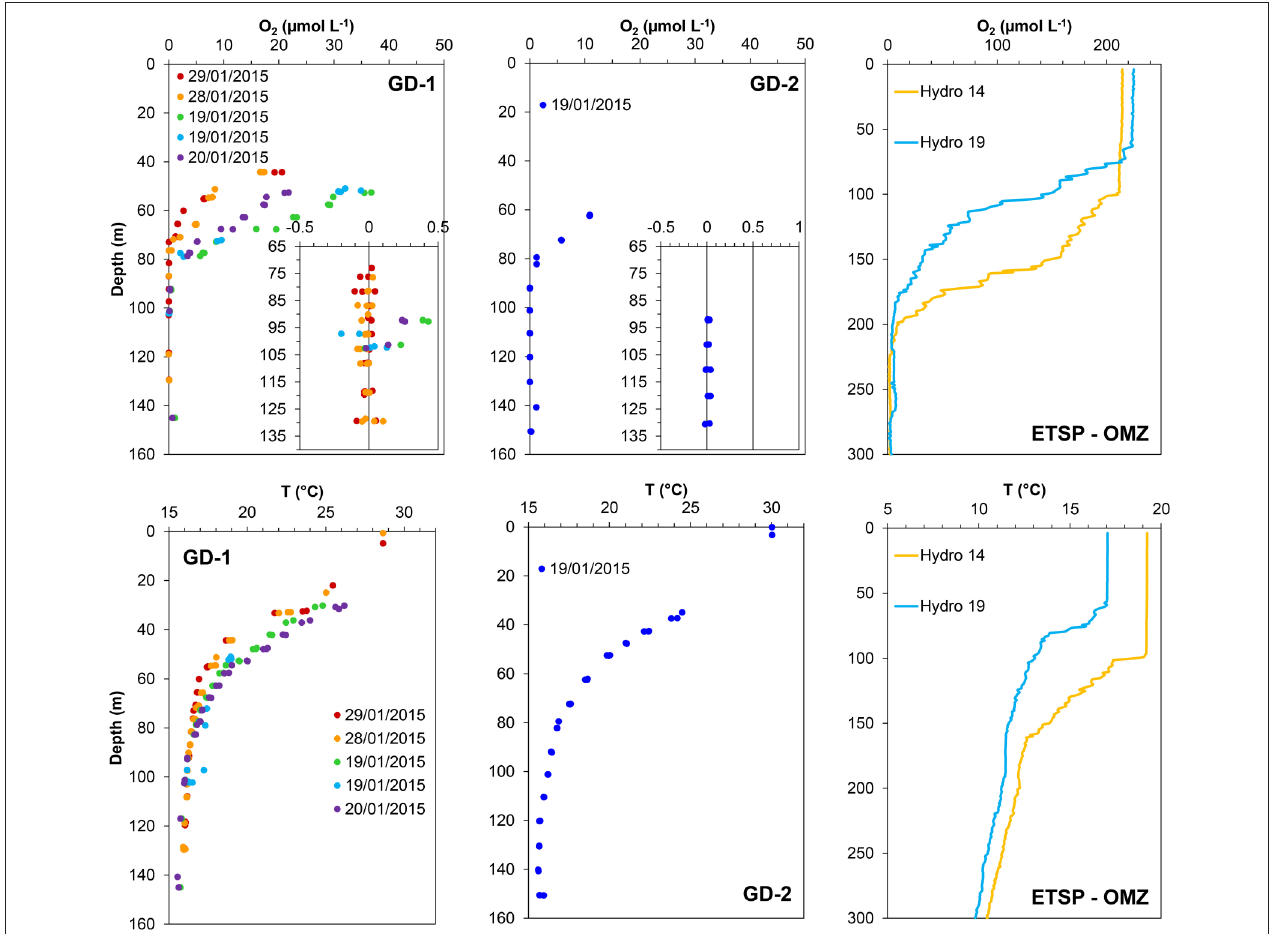
FIGURE 2 | Oxygen and temperature profiles measured at the sampled stations in Golfo Dulce (Costa Rica; GD-1 and GD-2) and in the East Tropical South Pacific Oxygen Minimum zone (ETSP-OMZ) off Chile-Peru (Stations Hydro 14 and Hydro 19). Oxygen was measured using STOX sensors in Golfo Dulce and SBE43 sensors in the ETSP-OMZ. Note the scale differences between